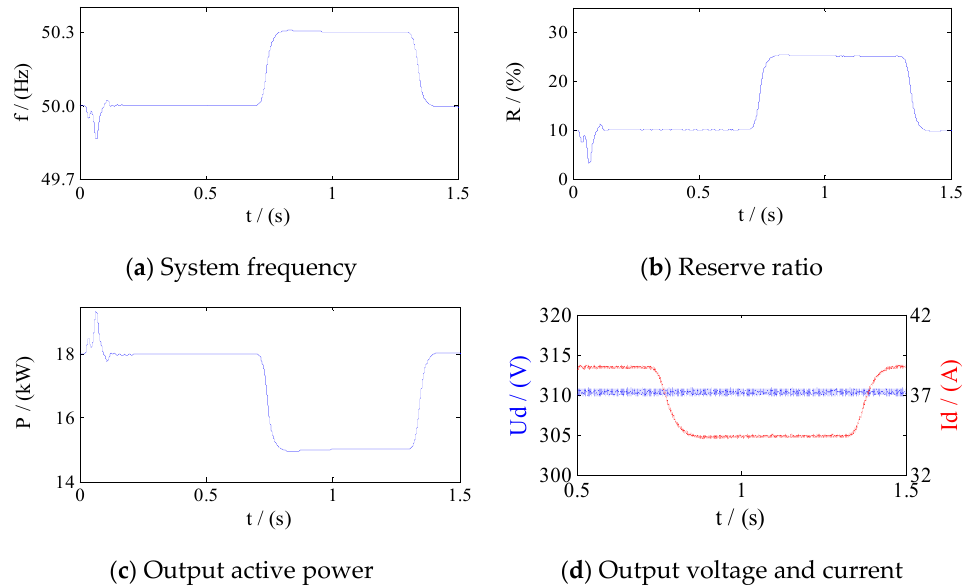
Figure 7. System output waveform when frequency increases by 0.3 Hz.